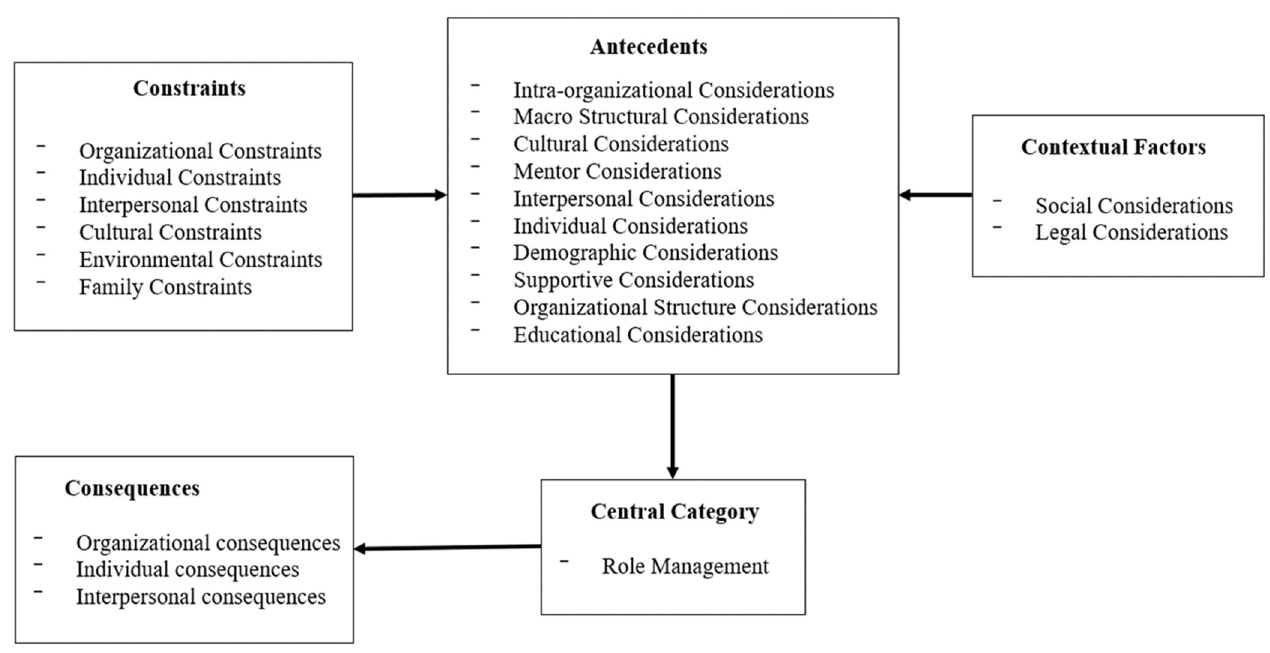
Figure 1. Framework of the impact of mentoring on women work-life balance.